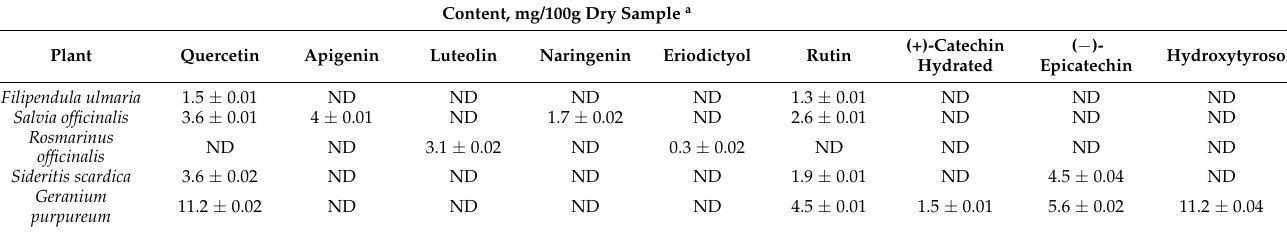
Table 3. Flavonoid concentration of plant extracts